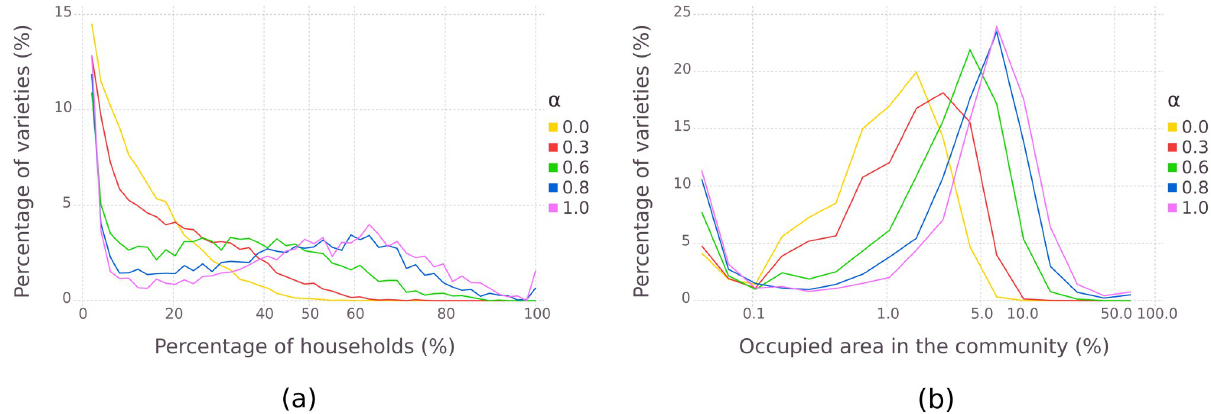
Fig 7. Distribution of variety evenness at the end of the simulation, with varying importance of productivity in the score ( α ). An α = 0 score only considers quality fitting, and an α = 1 score only considers productivity. Each line represents the aggregation of 200 runs. (a) Distribution of the presence of varieties in HDs. 100% indicates that the variety is in every HD of the community. (b) Distribution of the presence of varieties in community’s plot fractions.